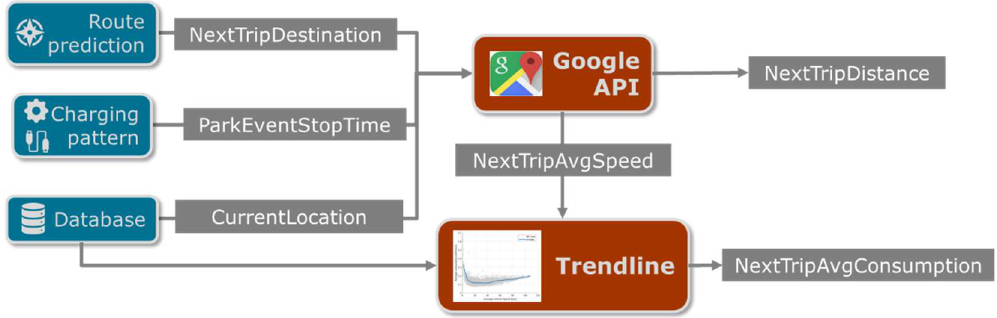
Figure 11. Google Application Programming Interface (API) and trendline usage for next trip distance and average consumption prediction.